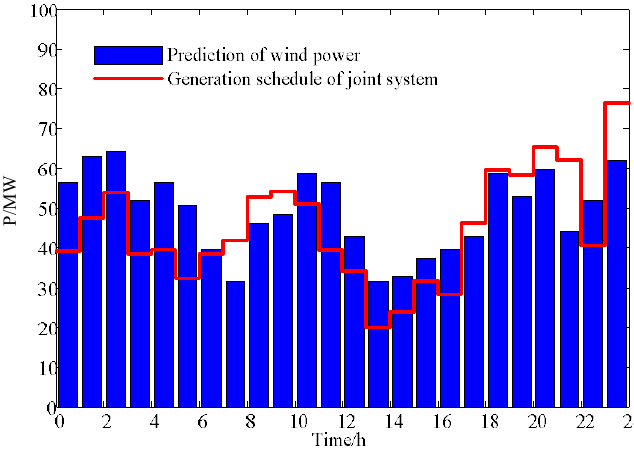
Figure 10. Comparison of the generation schedule of the integrated system and the wind power prediction.